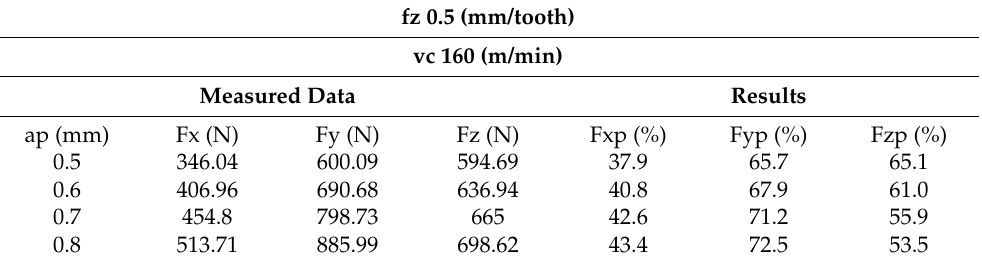
Table 11. Results for fz = 0.5 mm/tooth and vc = 160 m/min.